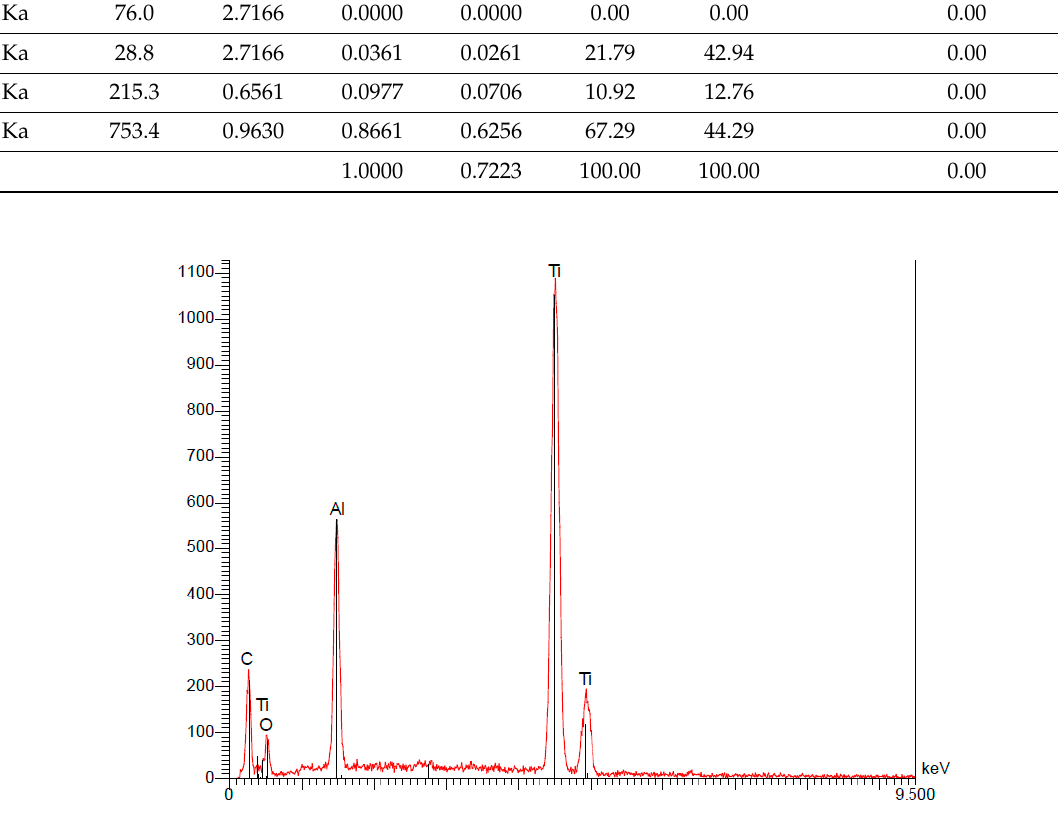
Figure 9. The spectroscopy of the Ikone implant’s neck. Table 7. The quantitative results of the EDS analysis of the Inkone implant’s neck demonstrating the weight percentages (P%) and atomic percentages (A%) of the elements detected.